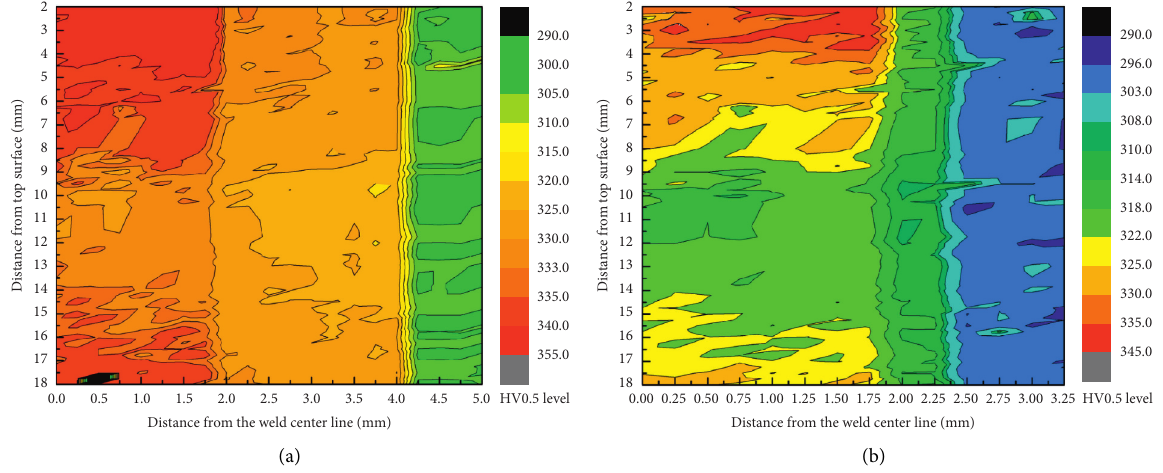
Figure 10: Microhardness distribution of weld metals jointed with different shielding gases: (a) Ar; (b)